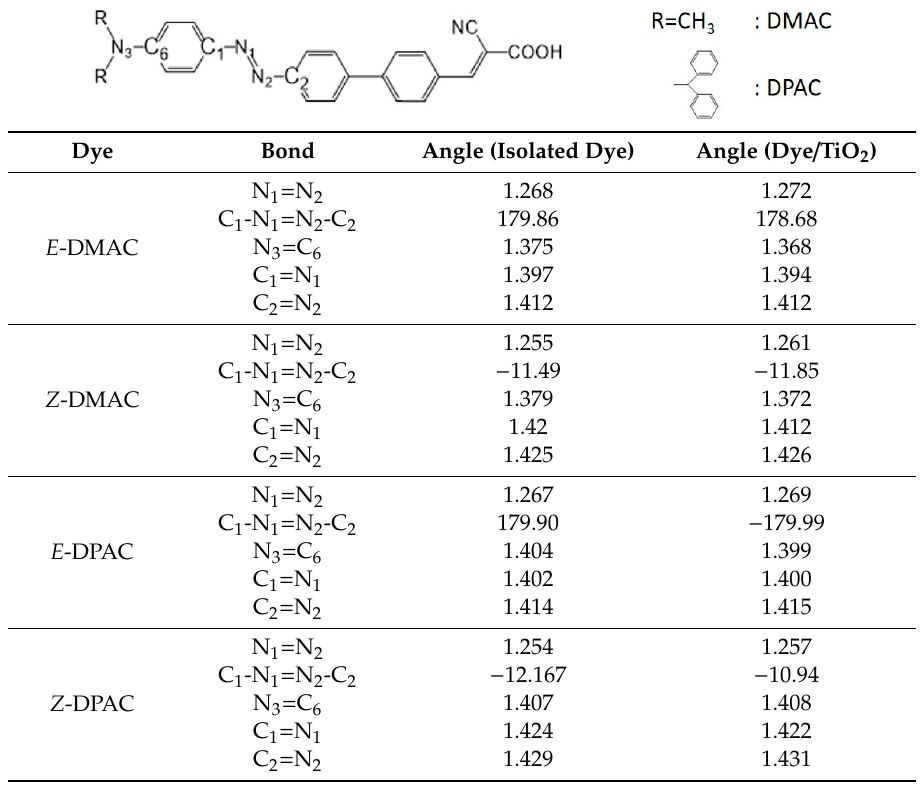
Table 1. Structural parameters of DMAC and DPAC as isolated dyes and dye/TiO 2 complexes. A schematic representation of the dye is shown